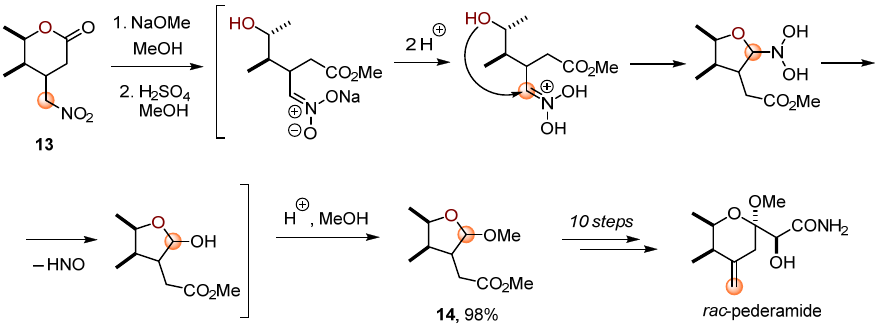
Scheme 6. Recyclization of nitrolactone 13 via an interrupted Nef reaction and application in the total synthesis of racemic pederamide.